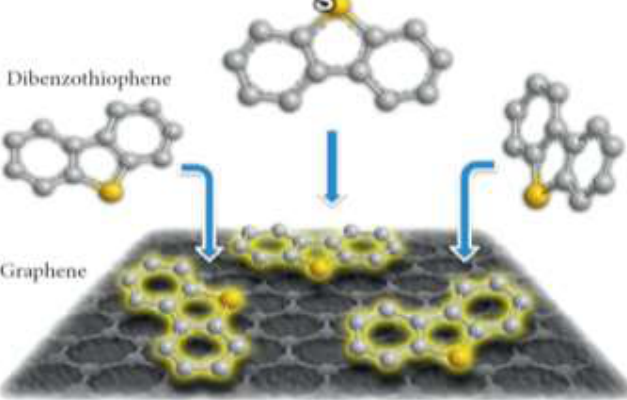
Figure 9: Adsorption of sulfur (DBT) on graphene via π-complexation [94].